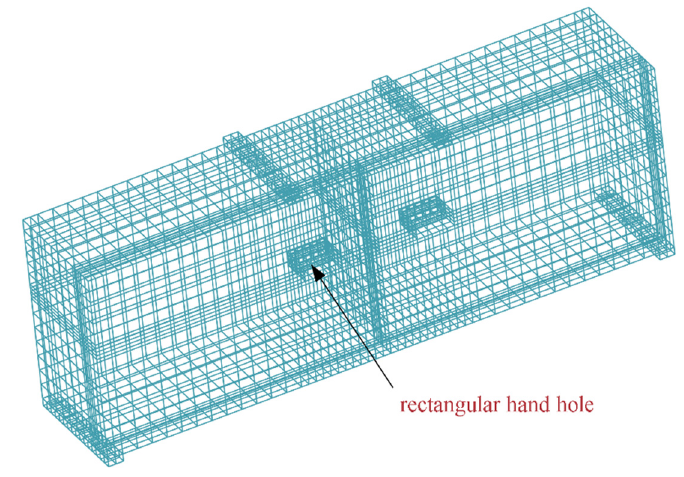
Figure 3. Meshing diagram of the single-layer lining segment.